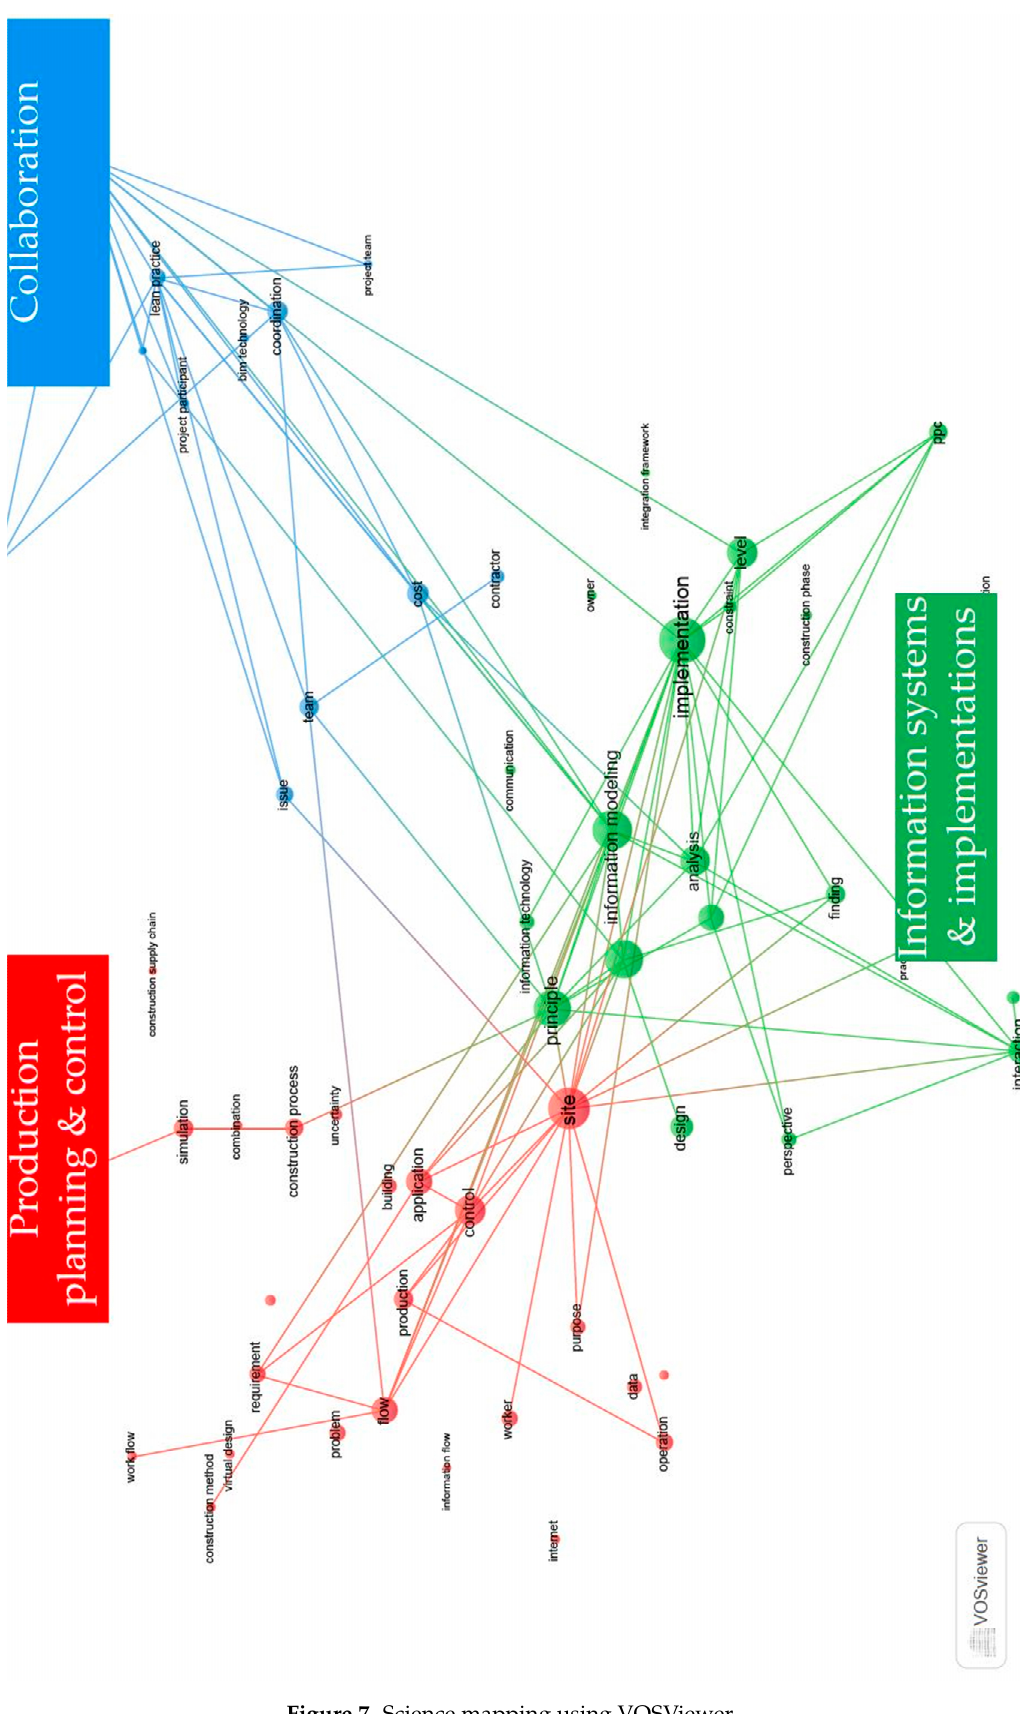
Figure 7. Science mapping using VOSViewer.